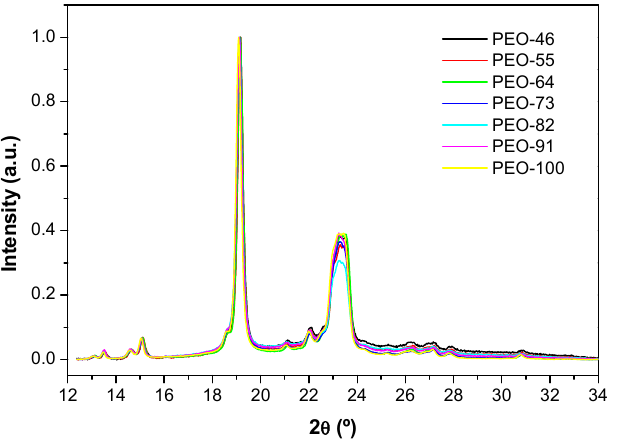
Figure 3. X-ray diffractograms of the blow spun PEO-based obtained from 10% wt solutions at different compositions Chl:Ac.